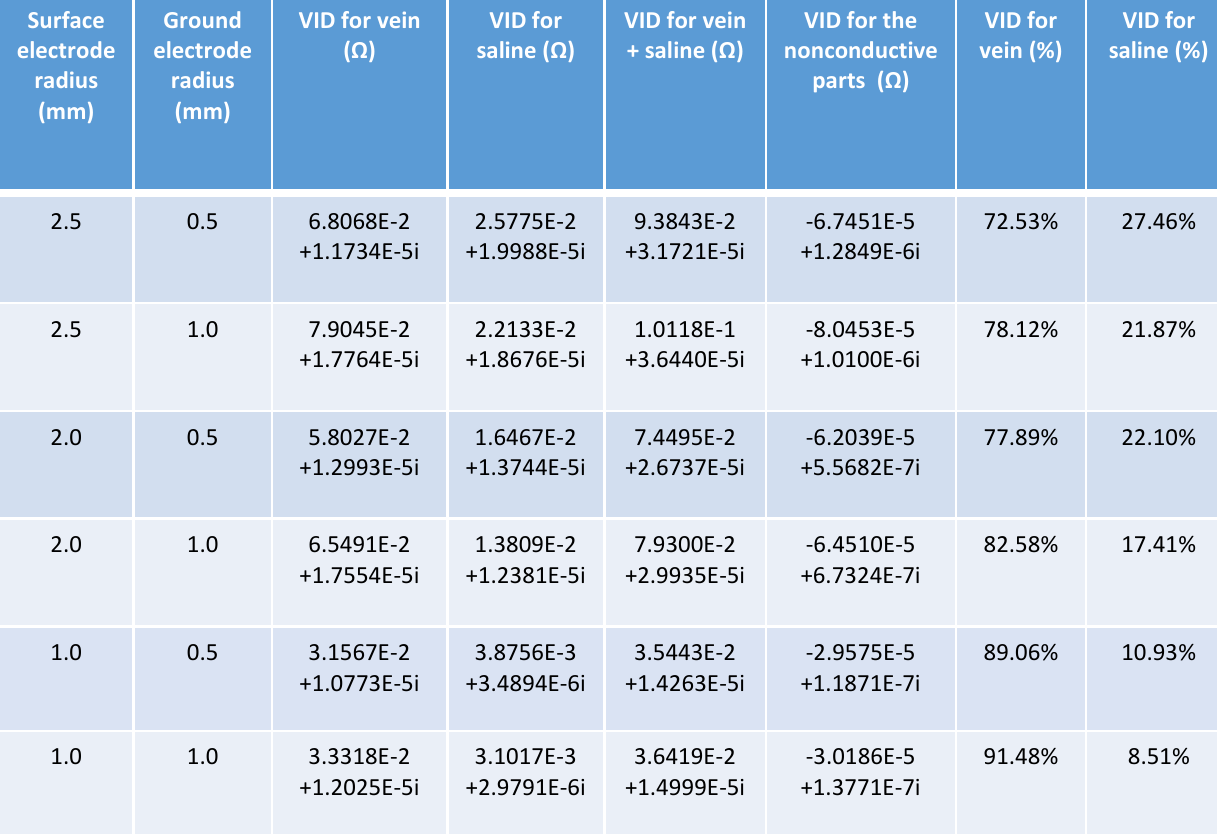
Table.11: Volume integration of Volume Impedance Density (VID) measurements at 1MHz with all the 32 surface electrodes excited simultaneously as terminals (8 electrodes in 4 rows)